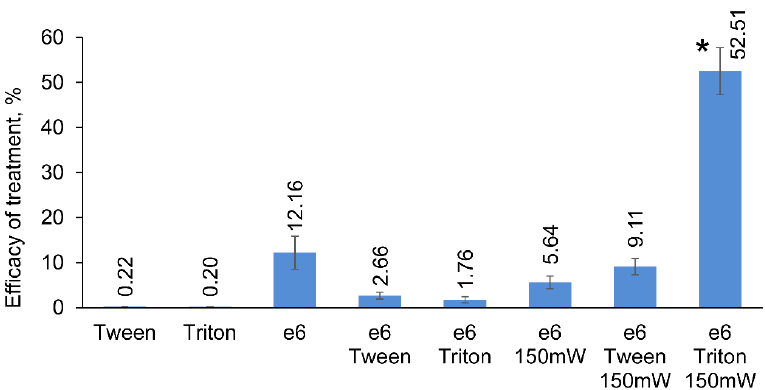
Figure 1. The influence of various components of aPDT and their combinations on E. coli viability. The following concentrations of agents were used for incubation with bacteria, 10% of Tween 80, 10% of Triton X-100 and 50 µ g/mL of Fotoditazin (e6). Bacteria were incubated for 15 min at room temperature in the dark. Before irradiation by continuous wave laser at 150 mW, bacteria were washed from unbound chemicals. Statistically significant difference comparable with e6 150 mW (*) is